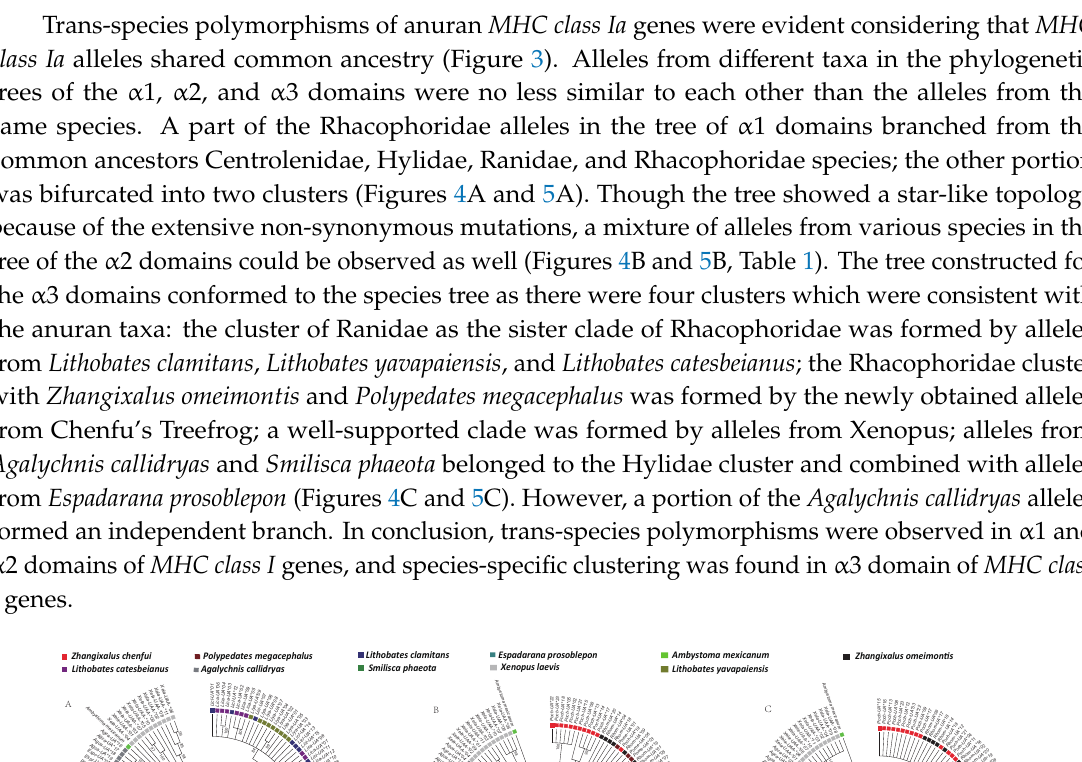
Figure 4. Phylogenetic relationships of α 1 ( A ), α 2 ( B ) and α 3 ( C ) domains (analysis by MEGA). All of the branches are proportional to the scale shown at the bottom left of the figure. Alleles belonging to di ff erent species are marked using di ff erent colors.